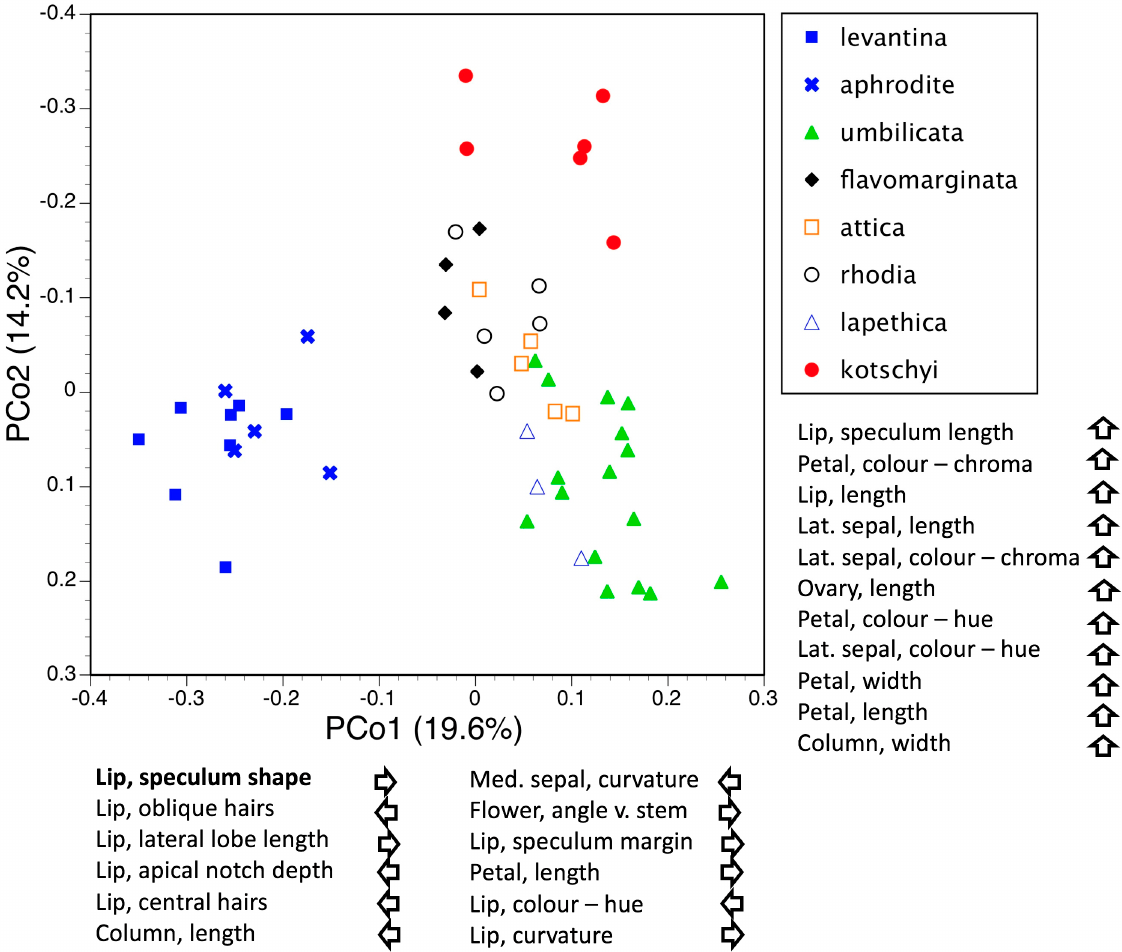
Figure 9. Plot of principal coordinates 1 and 4 for the macrospecies Umbilicata, labelled according to eight microspecies groups: 52 individuals from 44 localities and 51 variable characters. Characters contributing to each coordinate are listed in descending order, with arrows indicating the direction of increase in the value of each character (boldface characters dominate that coordinate).